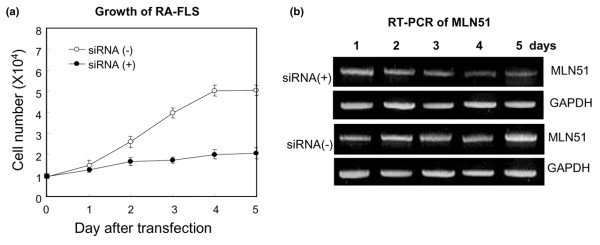
Effects of MLN51-knock-down on the growth of RA FLSs. (a) Fibroblast-like synoviocytes (FLSs; 104 cells; rheumatoid arthritis (RA) 2–14, at passage 5) were transfected with 4 μg of hMLN51 siRNA or control siRNA. The transfected cells were cultured in growth medium and counted each day for 5 days. The trypan blue exclusion method was used to evaluate cell proliferation. The results are means ± SD from single experiments performed in triplicate cultures. (b) MLN51 expression according to the above result was monitored by RT-PCR. See the Materials and methods section for a detailed description. This result is representative of two separate experiments.